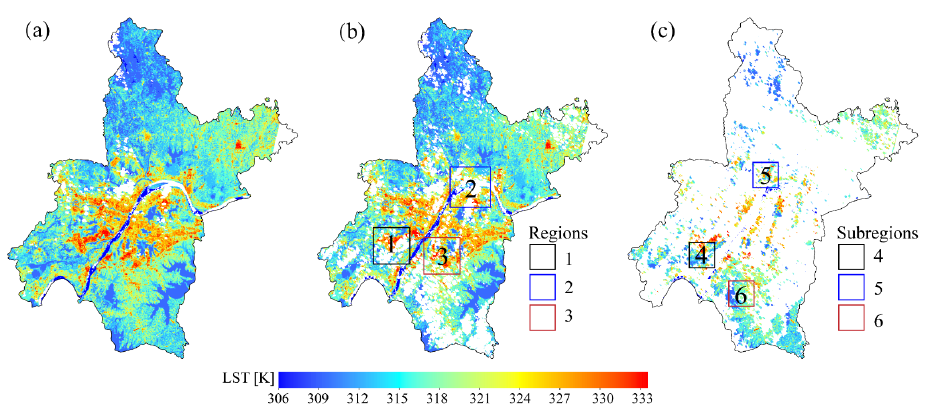
Figure 3. The 100 m LST data retrieved from Landsat 8 images by the PSC platform: ( a ) original LST; ( b ) extracted LST; and ( c ) masked LST. Regions 1, 2, and 3 and subregions 4, 5, and 6 show the specific areas selected for comparison.